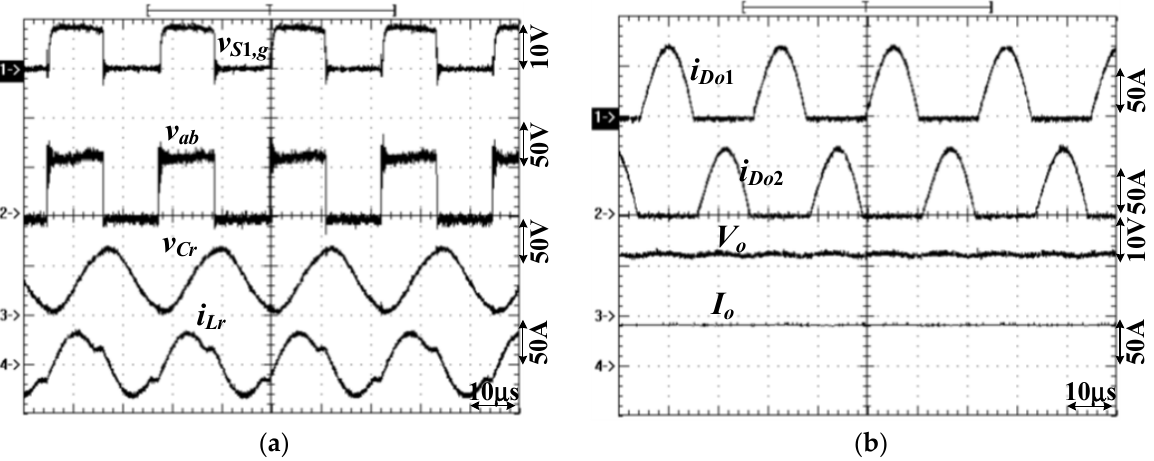
Figure 10. Measured results at V in = 67 V and P o = 500 W ( a ) v S 1, g , v ab , v Cr and i Lr ( b ) i Do 1 , i Do 2 , V o and I o .